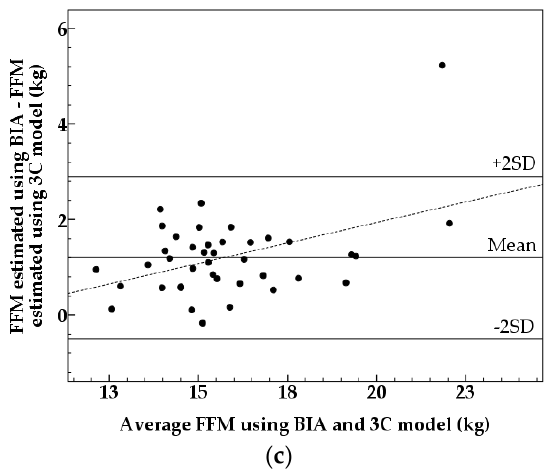
Figure 1. Bland and Altman plots comparing ( a ) body fat percentage (BF%) using BIA and the three component model (3C model) (mean difference: − 5.7%, limits of agreement (2SD): 6.6%); ( b ) fat mass (FM) (kg) using BIA and the 3C model and (mean difference: − 1.2 kg, limits of agreement (2SD): 1.8 kg) and ( c ) fat free mass (FFM) (kg) using BIA and the 3C model (mean difference: 1.2 kg, limits of agreement (2SD): 1.7 kg) in 40 healthy 5.5 years old children. The dotted line is the regression line. Regression lines: ( a ) y = 2.638 − 0.376 x ( r = − 0.513, p = 0.001); ( b ) y = 0.109 − 0.280 x ( r = − 0.705, p < 0.001), and ( c ) y = − 1.495 + 0.172 x ( r = 0.432, p = 0.005).